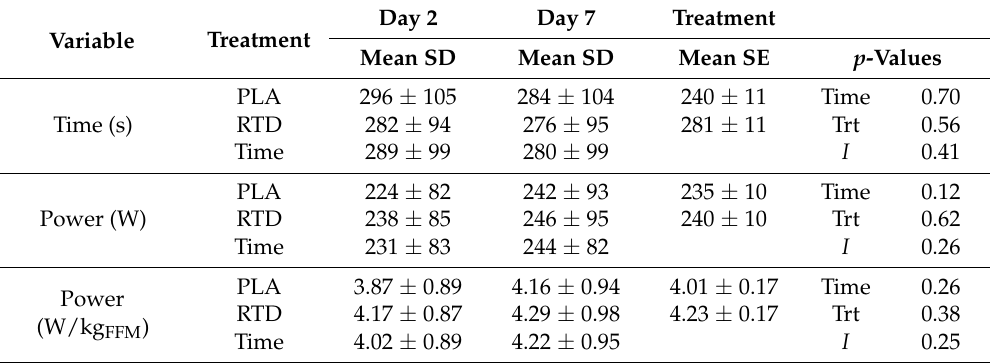
Table 3. Time Trial